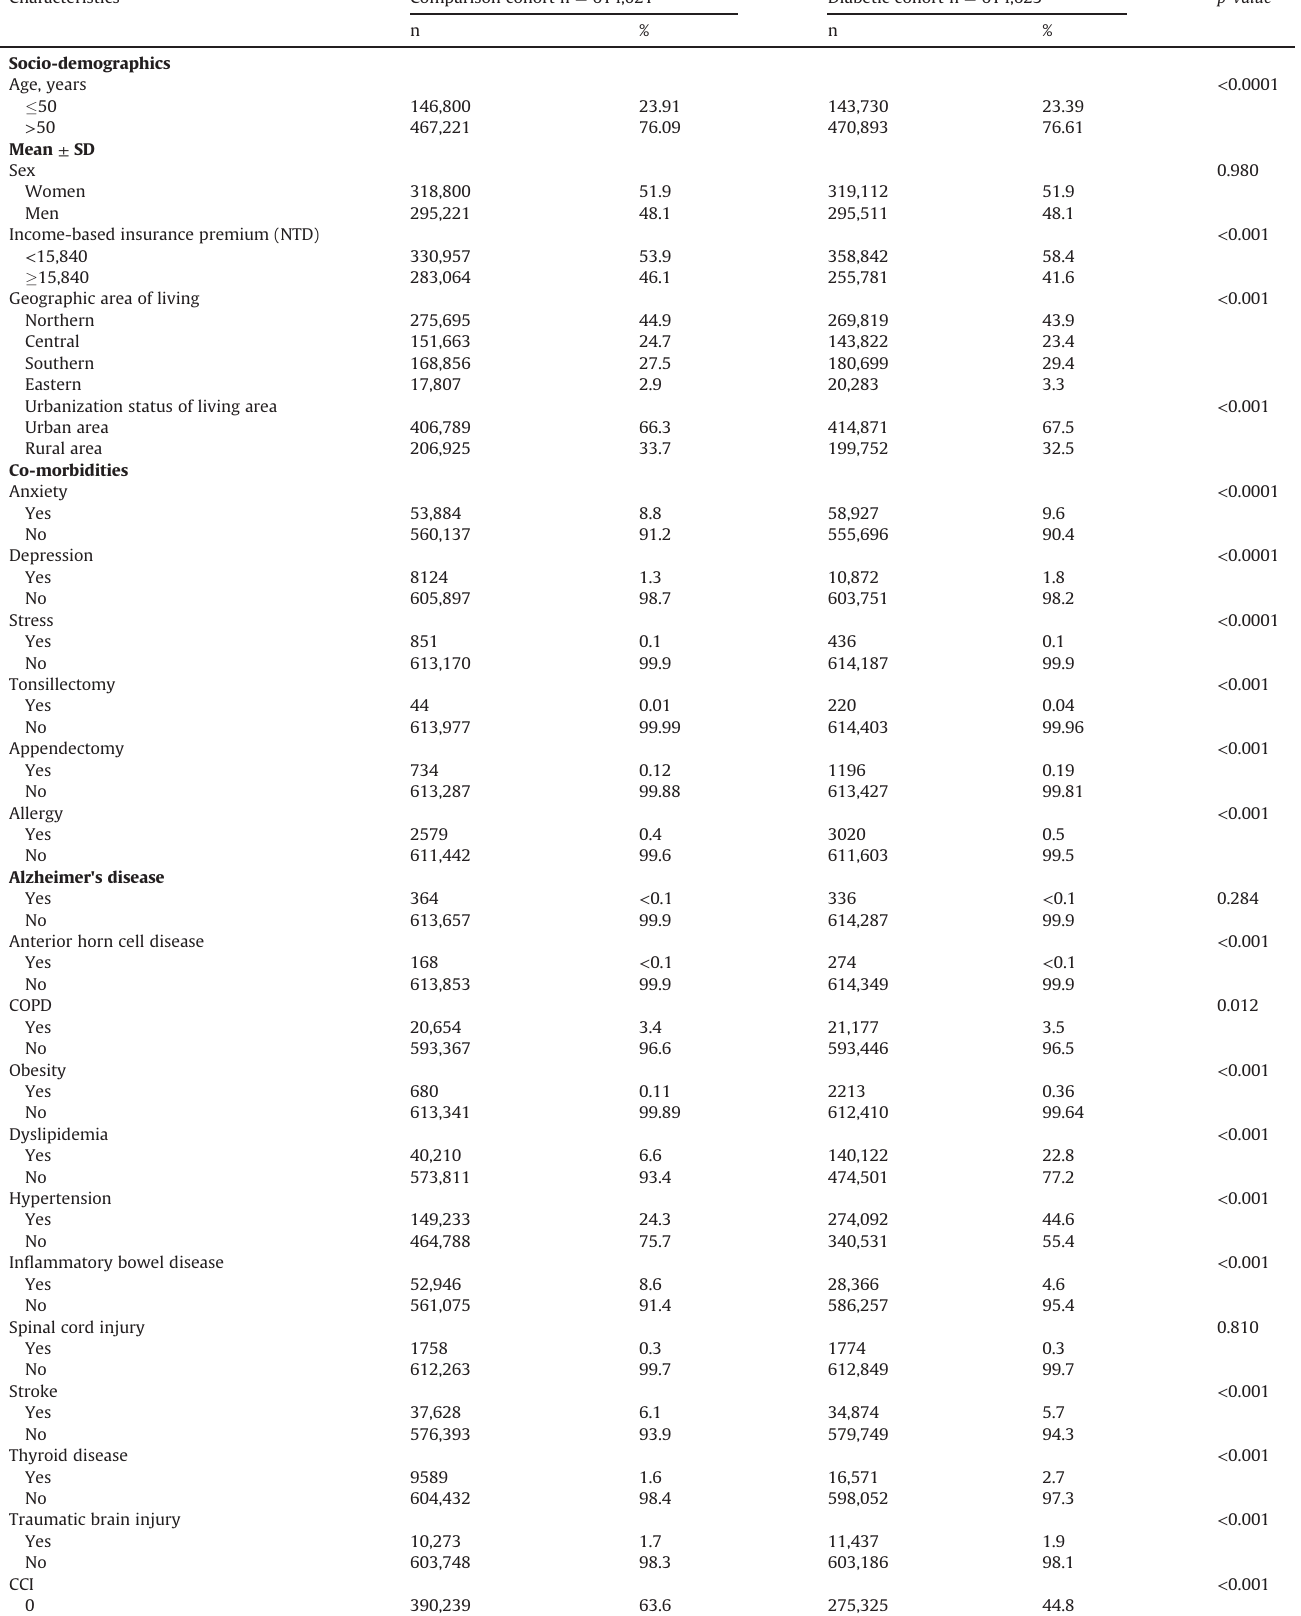
Table 1 Characteristics of the study